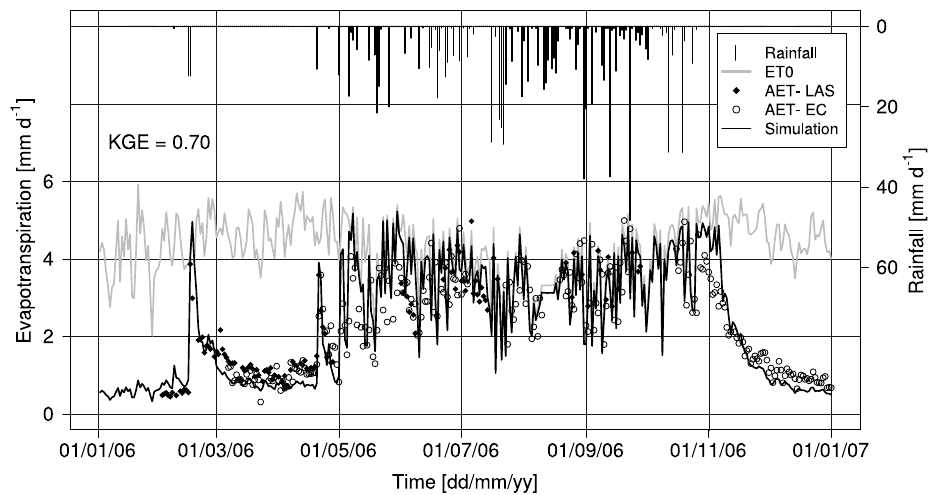
Fig. 6. Simulated and observed evapotranspiration, averaged over the elementary hydrological unit, for year 2006. Actual evapotranspiration is measured by LAS (AET-LAS) or by eddy covariance (AET-EC).